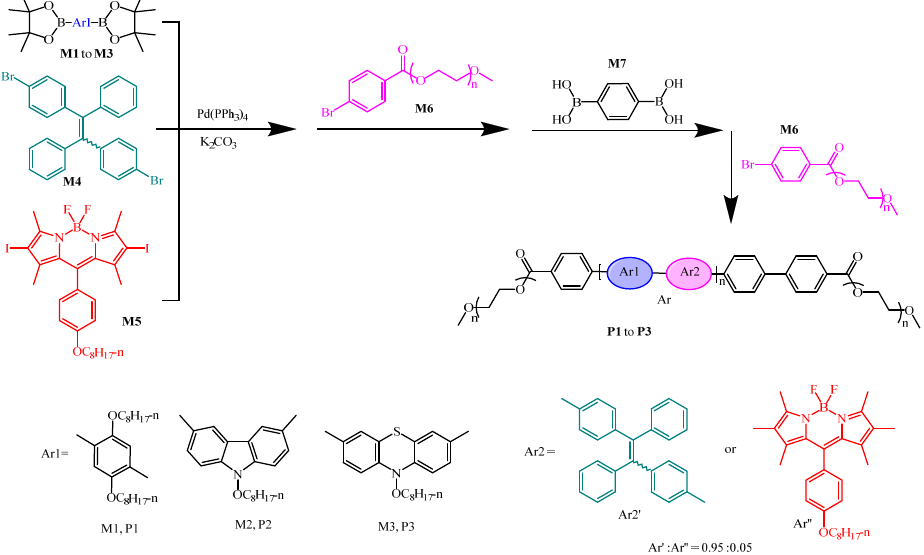
Figure 29. Schematic representation of multicolored AIE-active polymeric dots (Pdots) for drug delivery.